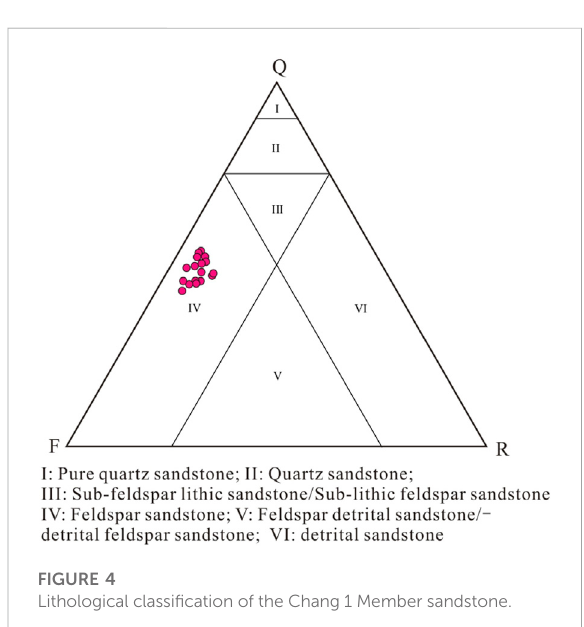
FIGURE 4 Lithological classi fi cation of the Chang 1 Member